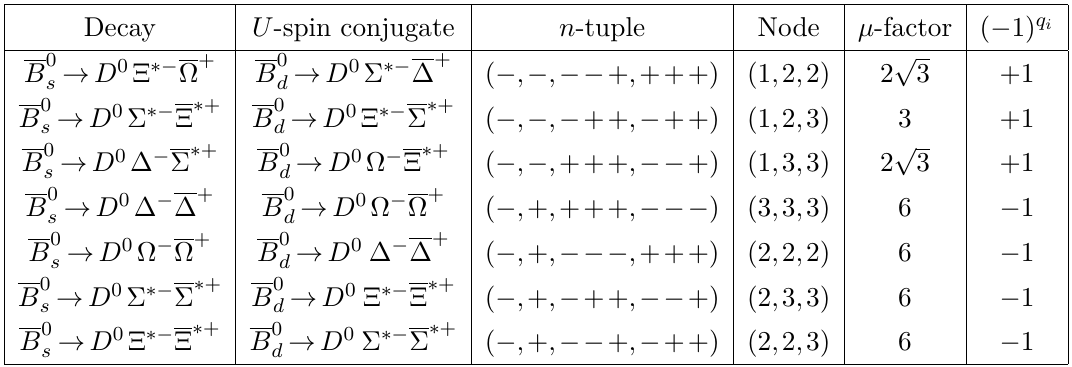
Ω + decays into generalized n B B